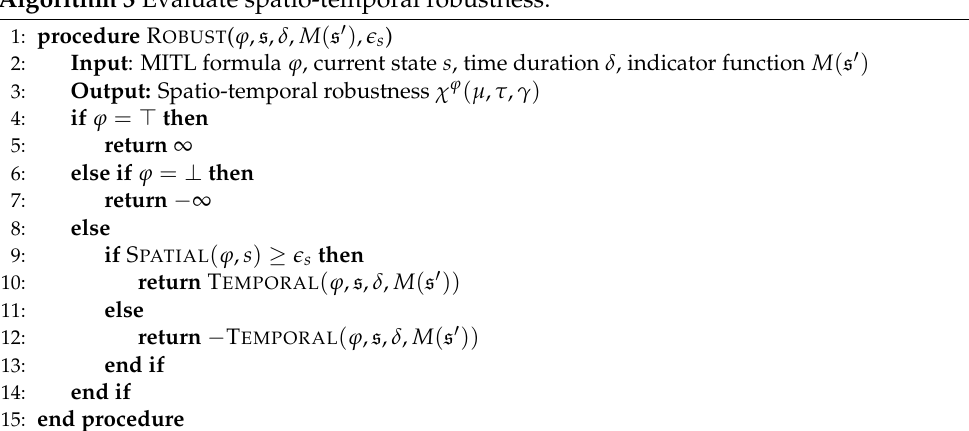
Algorithm 3 Evaluate spatio-temporal robustness.